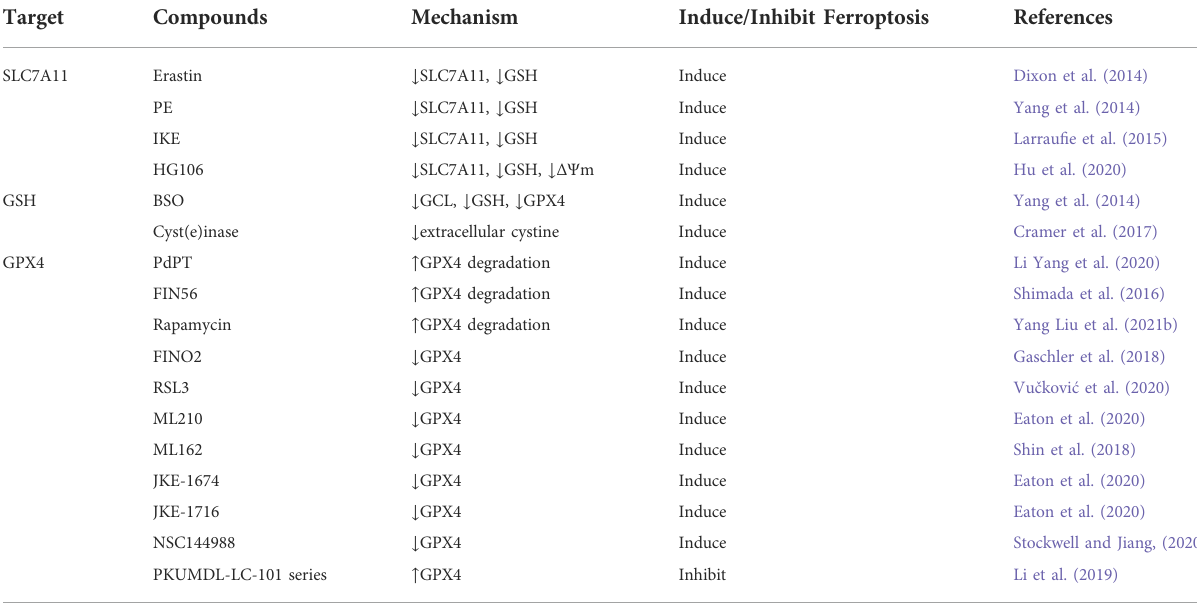
TABLE 1 The regulatory small molecule compounds of targeting System X c − /GSH/GPX4 axis in